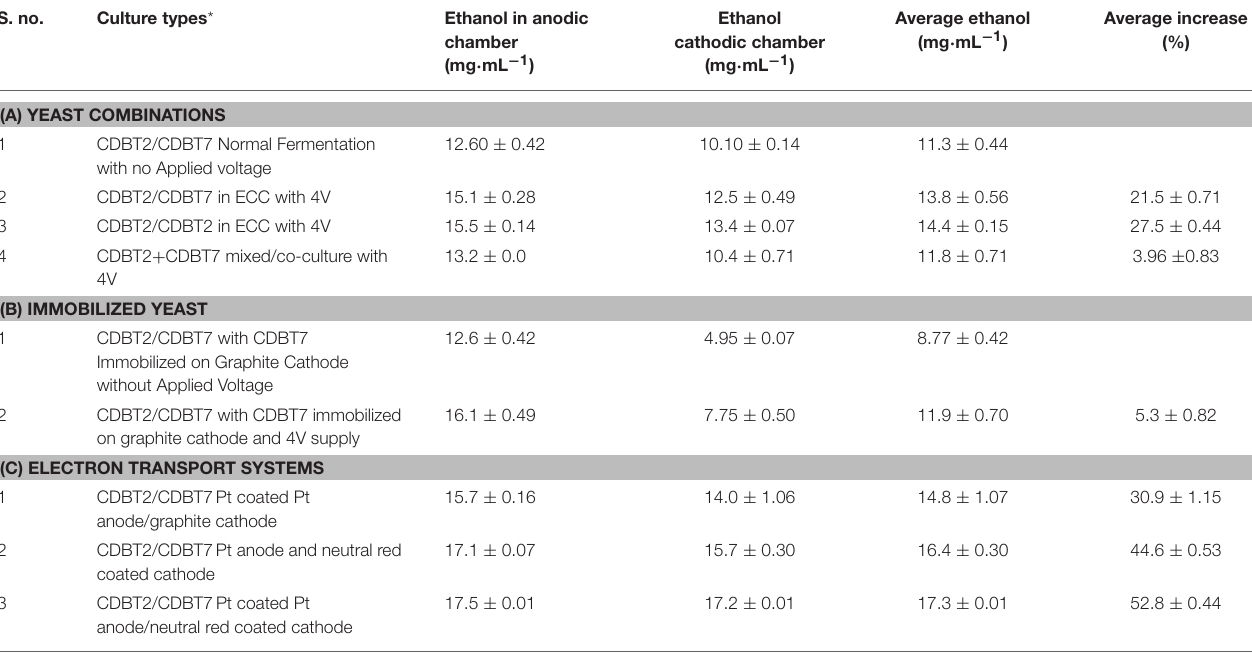
TABLE 2 | Ethanol production in an ECC with various combinations of anodic and cathodic systems for electron transport enhancement: summary. S.